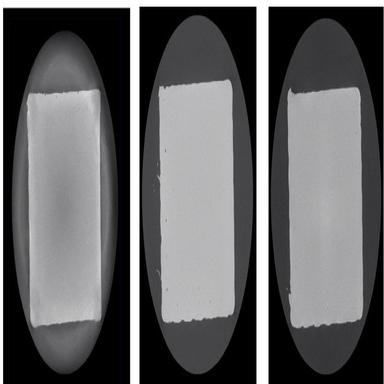
CT scanned cross-sections of cuboid geometry. Left-right: bottom, centre, top.